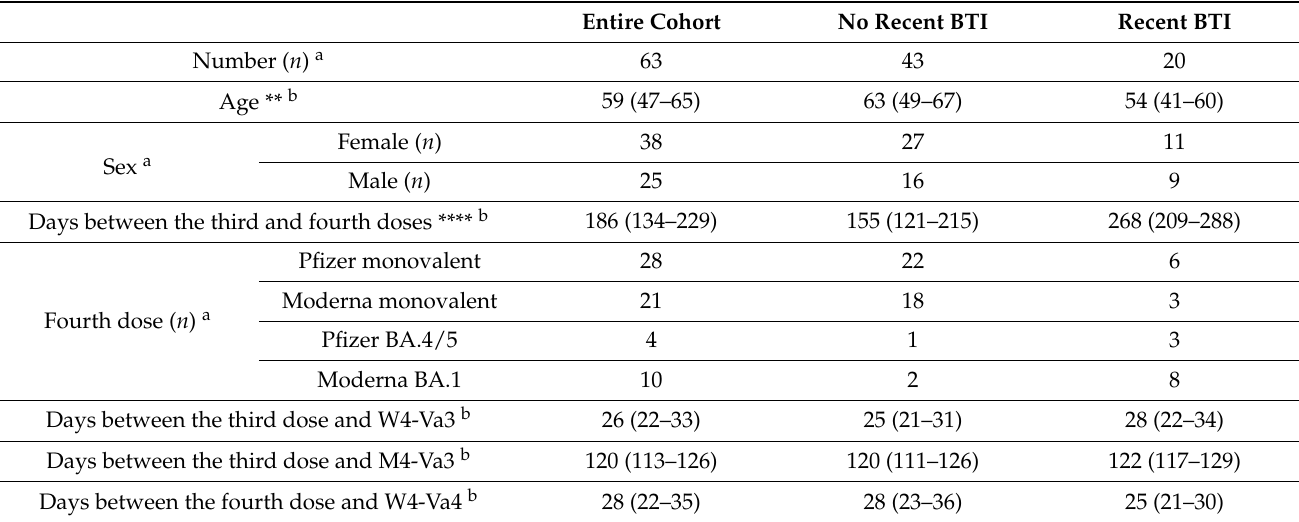
Table 1. Characteristics of the SARS-CoV-2 vaccinated